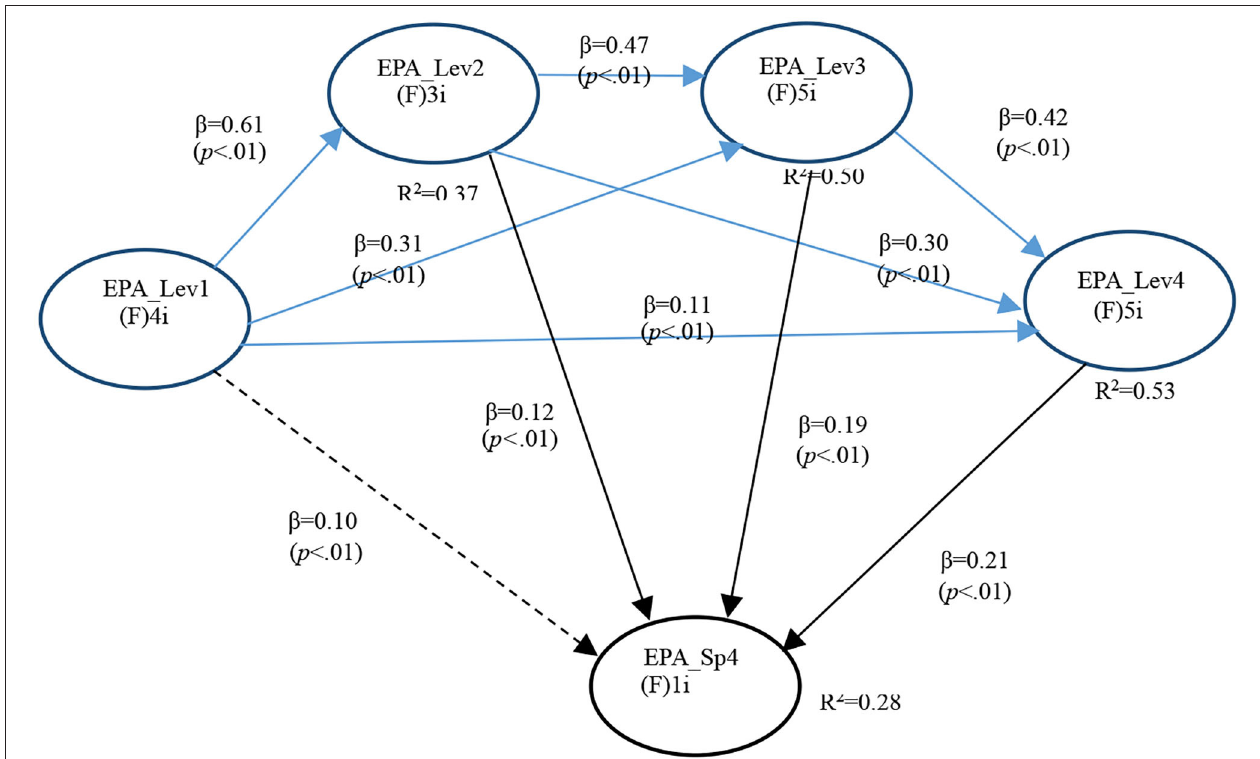
FIGURE 4 | Full model for GI EPA 4.